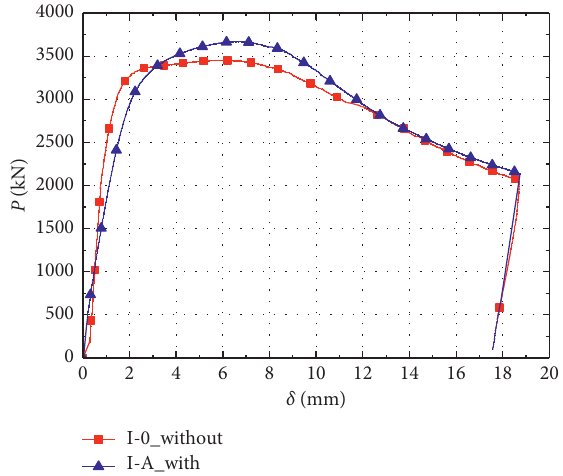
Figure 8: Effects of longitudinal stiffeners on steel tubular plate.